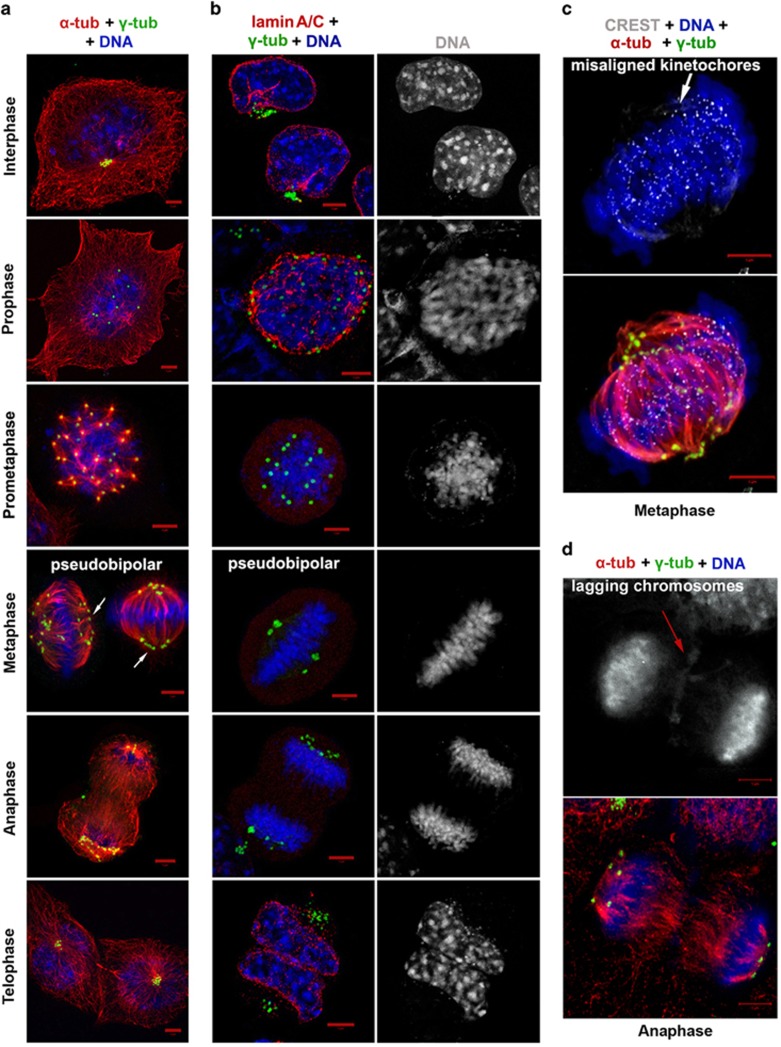
Cell cycle phase characterization of N1E-115 cells. (a) Representative immunofluorescence confocal micrographs depicting centrosome status in all cell cycle phases of N1E-115 cells. N1E-115 cells in interphase possess an enormous number of centrosomes as evident by γ-tubulin immunostaining (green). We acquired images as z-stacks with the slice interval of 0.40 μm. Z-stack slices encompassing the entire depth of the cell were then merged, and γ-tubulin-positive spots were counted in interphase cells from randomly selected fields totaling 200 interphase cells. (b) Representative immunofluorescence confocal micrographs showing lamin A/C staining (red) across all cell cycle phases to visualize nuclear membrane in order to distinguish interphase declustering from prophase scattering of centrosome cluster. (c) Confocal micrograph of a metaphase cell stained with CREST antibodies (white), antibodies against α-tubulin (red) and γ-tubulin (green) and 4,6-diamidino-2-phenylindole (DAPI; blue) to detect microtubule-kinetochore attachments and DNA in a pseudobipolar mitotic spindle. (d) Representative micrograph of an anaphase cell immunostained for α-tubulin (red), γ-tubulin (green) and DAPI (blue) showing lagging chromosomes. Scale bar, 5 μm